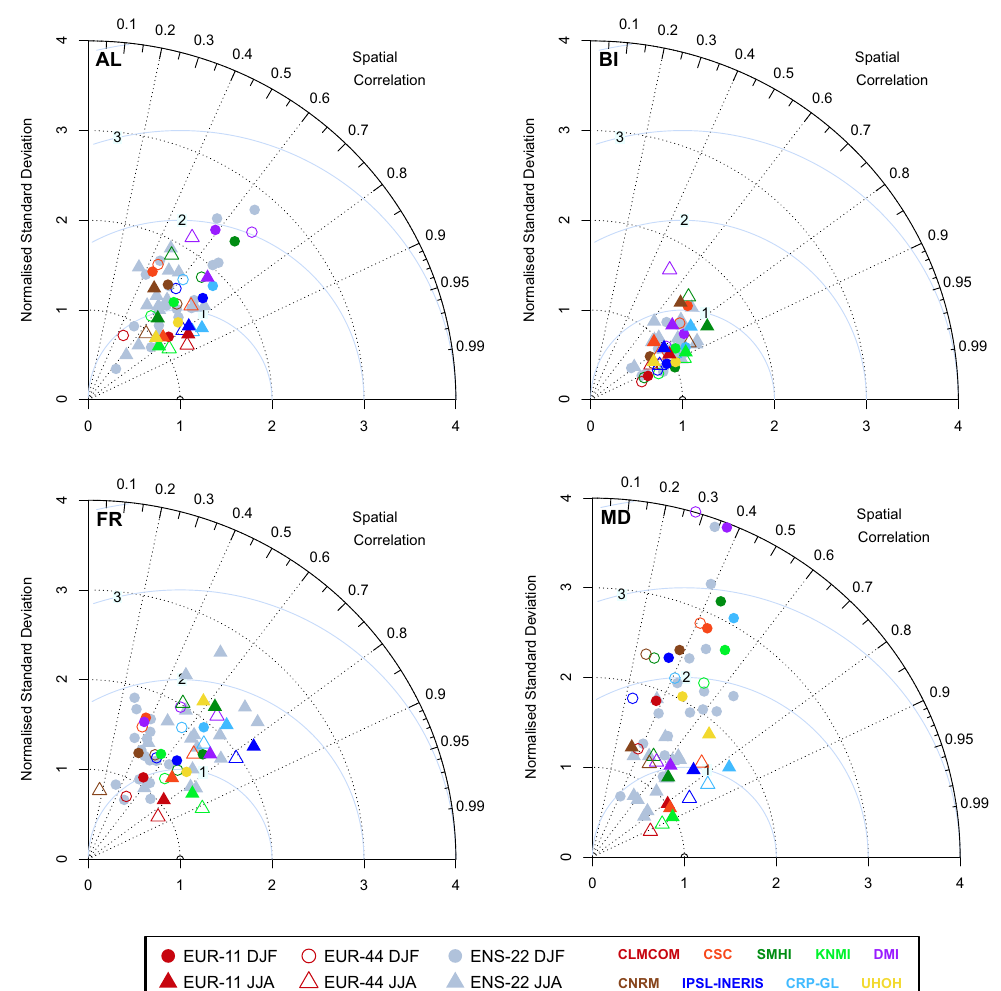
Figure B6. As Fig. B5 but for mean winter (circles) and mean summer (triangles) precipitation. See Fig. 10 for subdomains EA, IP, ME and